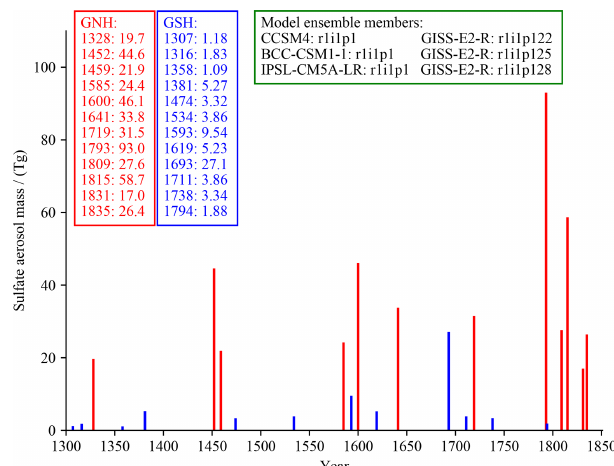
Figure 2. Volcanic years and the hemispheric volcanic aerosol in- jection magnitudes (Tg) in the GNH (red lines and text) and GSH (blue lines and text) classifications based on the GRA volcanic forc- ing (following Schmidt et al., 2021, reconstructed by Gao et al., 2008). Model ensemble members used in this study are shown in the green